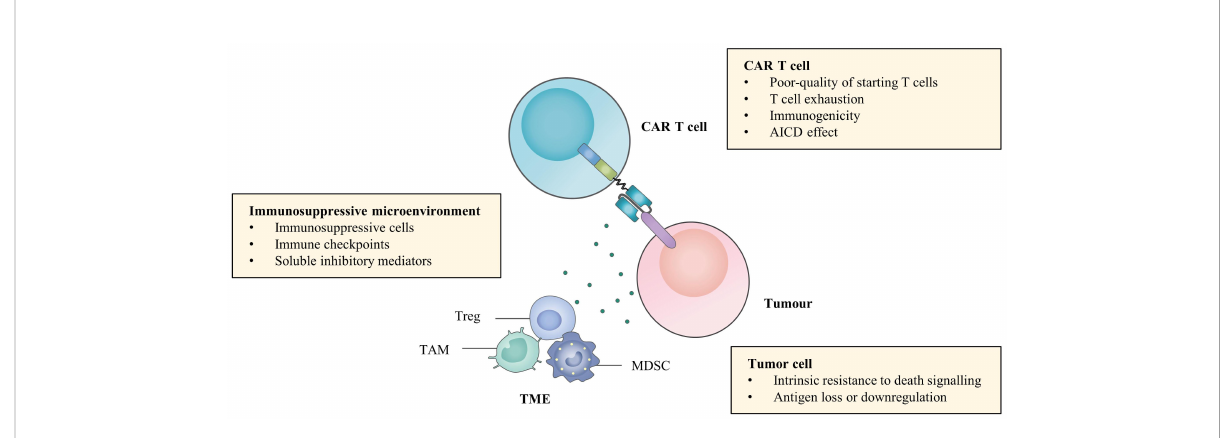
FIGURE 1 Challenges of ef fi cacy of CAR T cell therapy. Limited ef fi cacy of CAR T cell therapy in haematological malignancies can be attributed to poor persistence of CAR T cells, antigen modulation and intrinsic resistance to death signalling of tumour cells and immunosuppressive